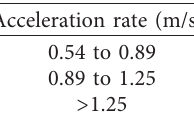
Table 1: Design consistency evaluation